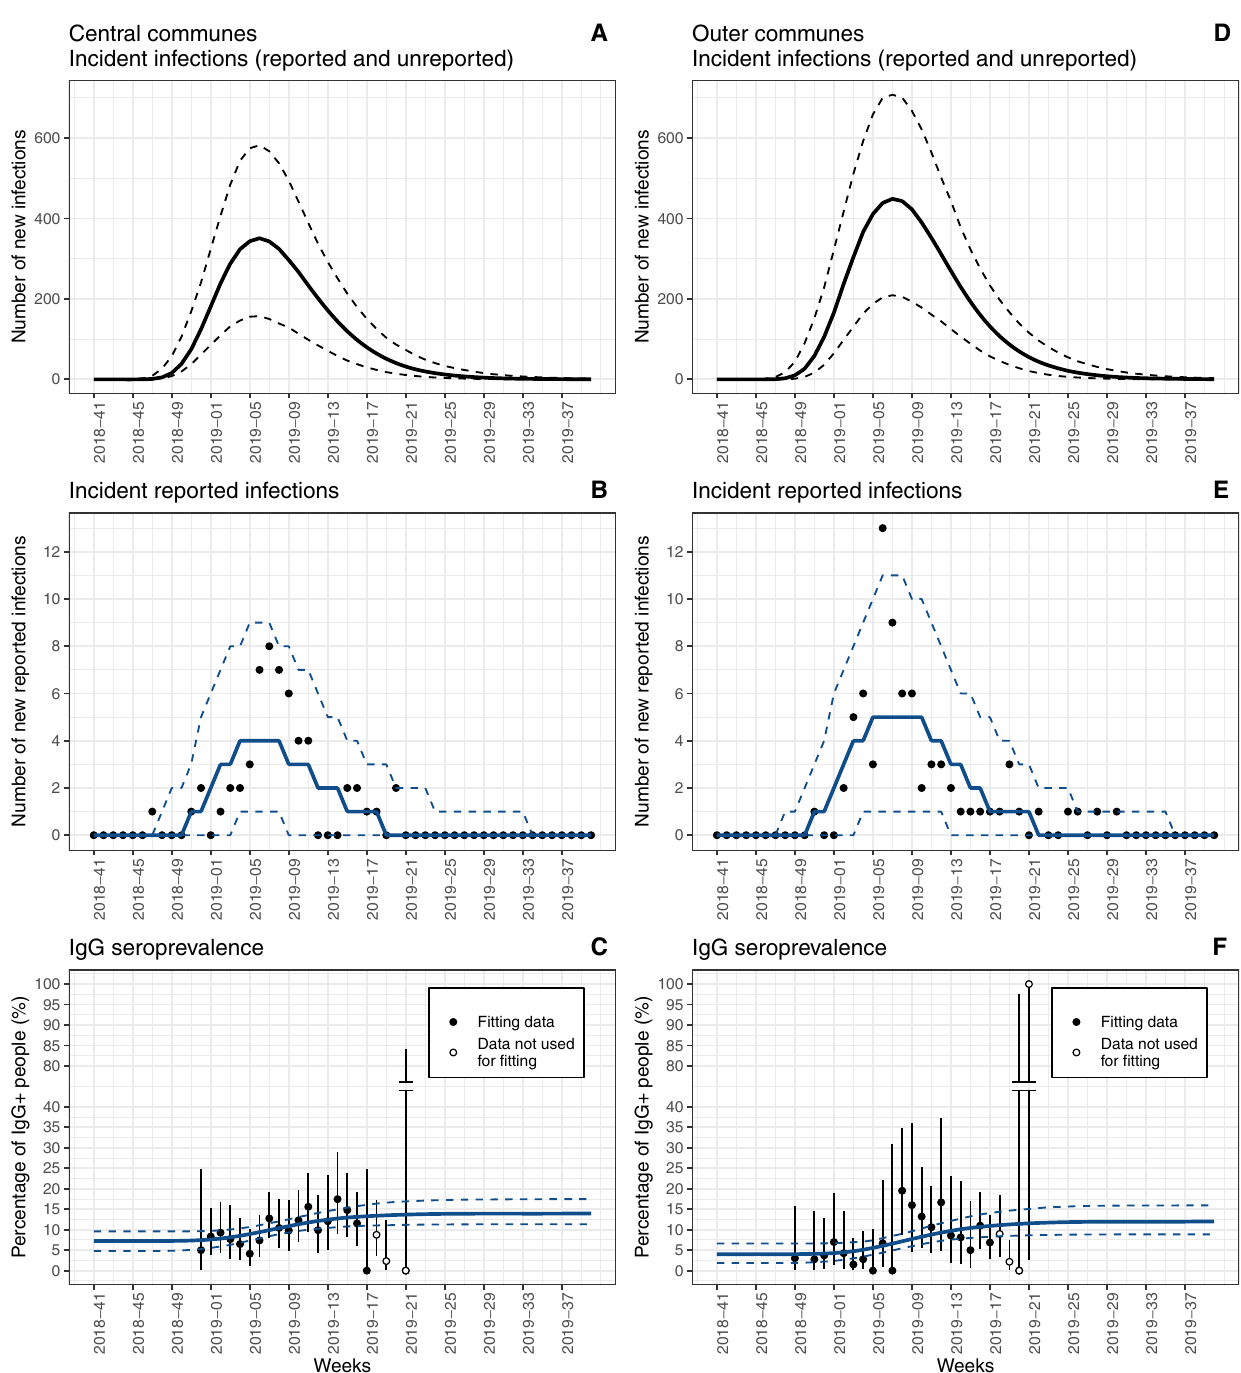
Fig. 3 Time course of the RVF outbreak in humans. Predicted number of weekly incident human infections, reported or unreported to the surveillance system ( A , D ), number of incident human infections reported to the surveillance system ( B , E ), and IgG seroprevalence in humans ( C , F ), in the population over 15 years old. A – C Represent Central Communes while D – F represent Outer Communes of Mayotte. Lines (solid and dashed) are model predictions (median and 95% prediction interval respectively, 5000 repetitions of the model). Dots are observed data (number of reported cases ( B , E ) and proportion of IgG seropositive tests ( C , F )). Vertical bars ( C and F ) are 95% con fi dence interval for the proportion (Clopper-Pearson method). Serological data from week 2019 – 18 (early May 2019) onwards were not used for model fi tting, because the representativeness of the sampled population was compromised (see Methods). In C and F , for visualization purposes, the Y -axis is cut between 40 and